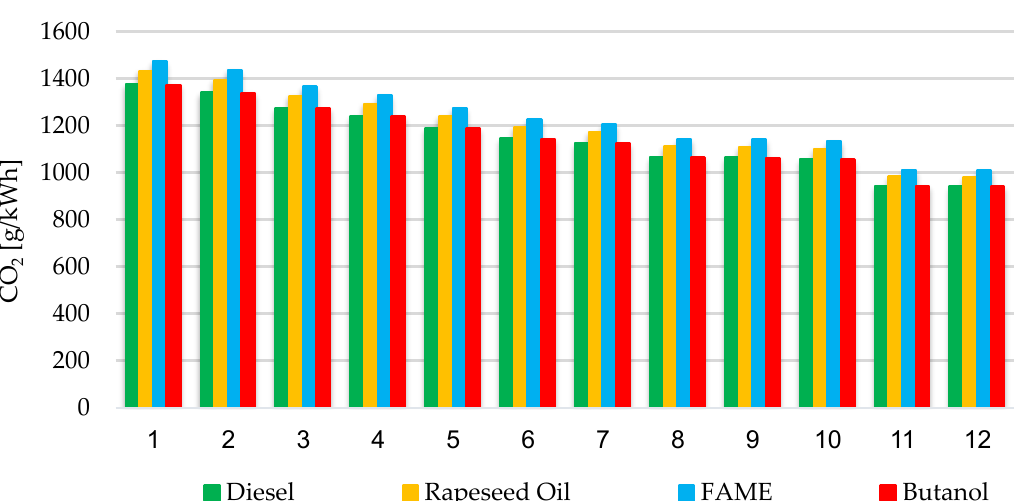
Figure 15. Summary of carbon dioxide emissions in tests for 1 kilowatt hour: 1—FTP 75; 2—NEDC; 3—Random Cycle Low (x05); 4—US SC03; 5—CADC without MOT; 6—WLTC 3b random; 7—MAC TP cycle; 8—US highway; 9—CADC shortened; 10—CADC; 11—US 06; 12—Random Cycle High (x95).